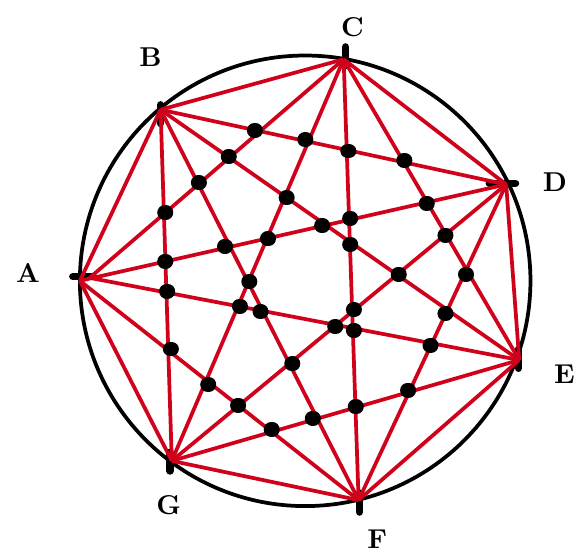
Figure 9 . Chord construction for 7 atomic regions. Draw chords for the edges of the bulkless graph, then place a new vertex wherever two chords intersect, to produce a planar graph with O ( N 4 ) vertices and edges. Any given edge e of the bulkless graph gets broken up into many (up to O ( N 2 ) ) new edges, each of which inherits the same weight w ( e ) that the parent edge e